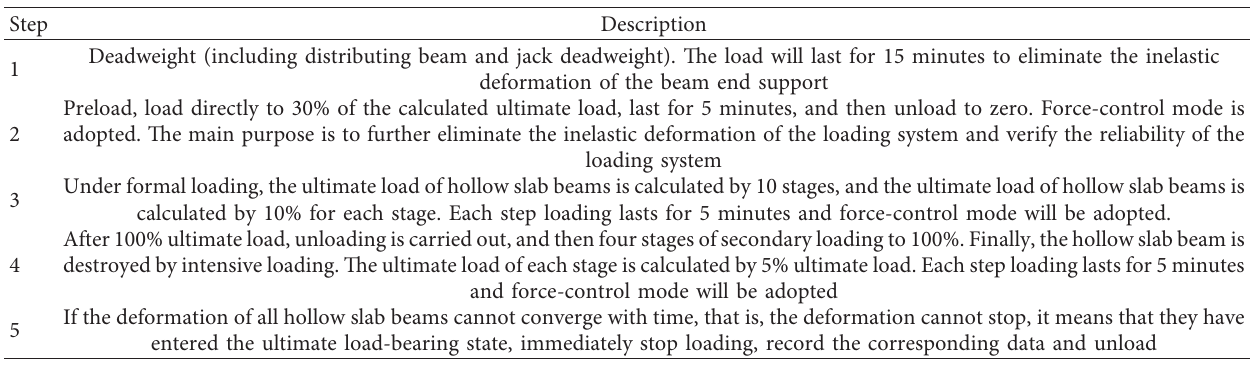
Figure 4: The on-site loading situation. Table 3: Loading process for hollow slab beams.